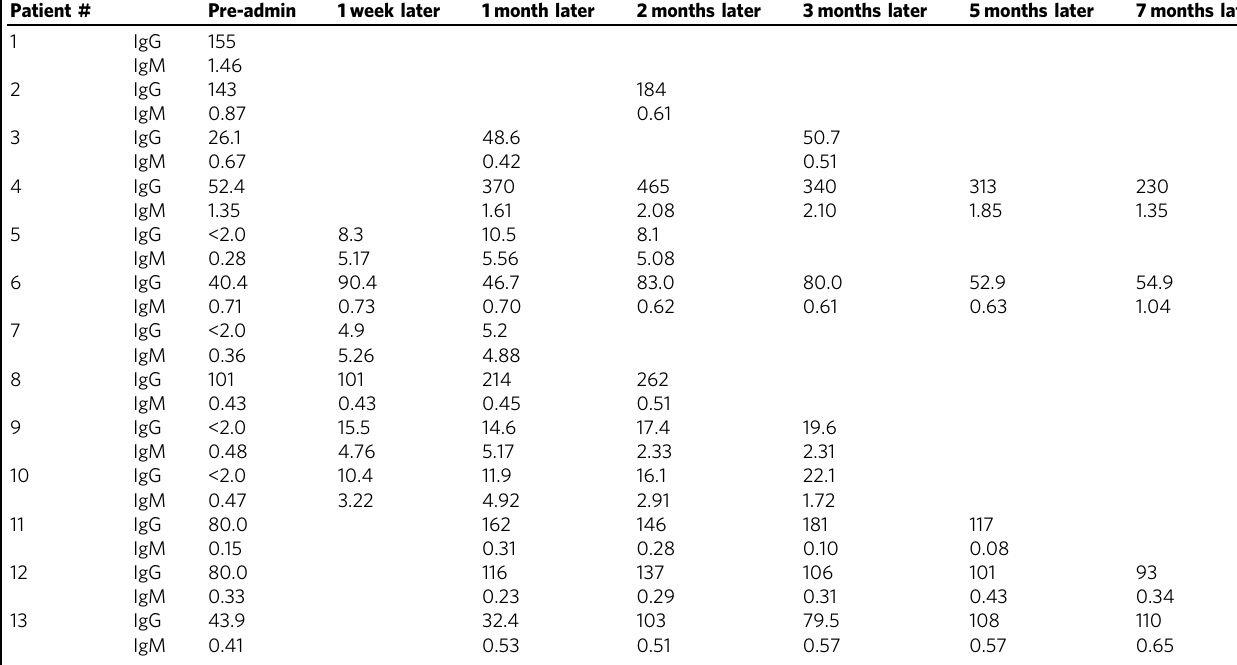
Table 4 Time course of serum anti-HSV-1 antibodies.